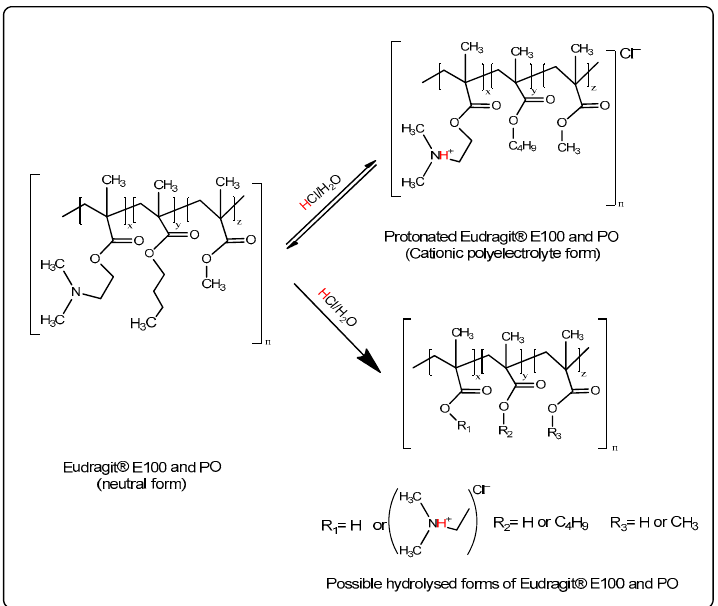
Figure 1. Presumptive scheme of the ionisation and hydrolytic degradation of Eudragit ® E-100 and Eudragit ® PO under acidic conditions.